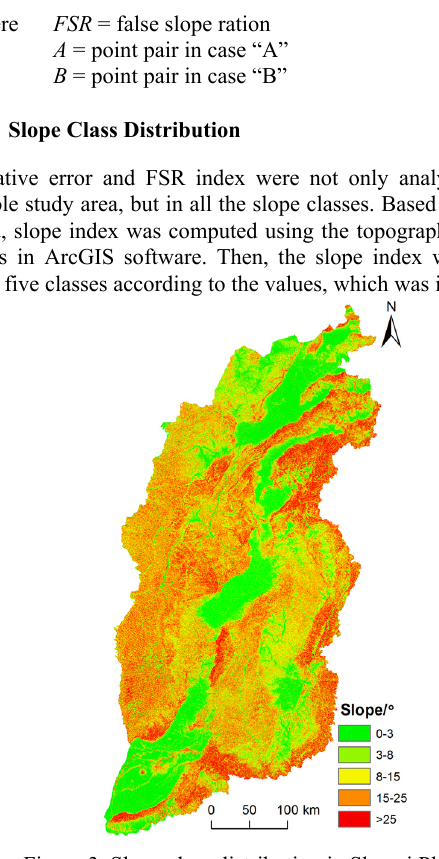
Figure 3. Slope class distribution in Shanxi Plateau